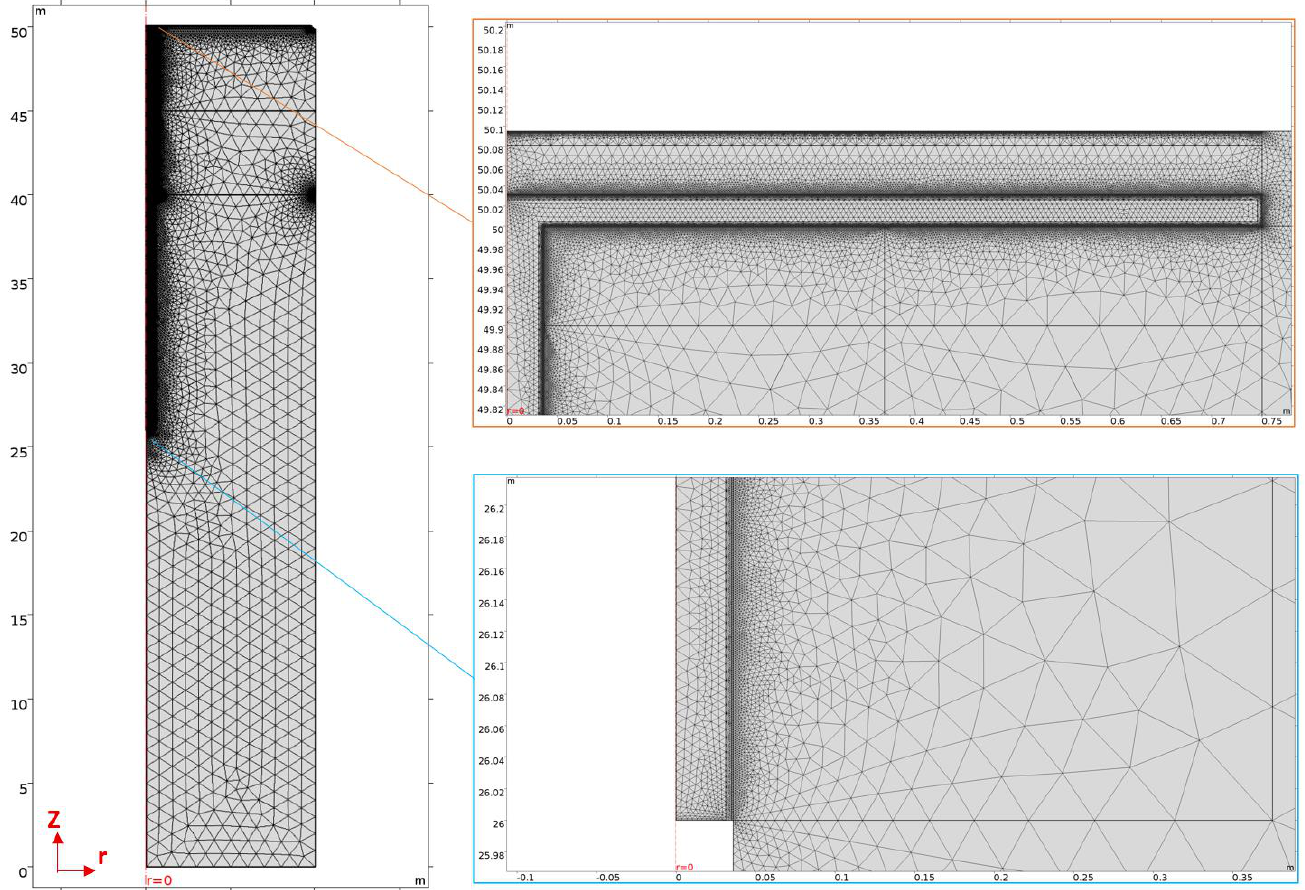
Figure 2. Identify the CO2-GSHP model mesh on the axisymmetric